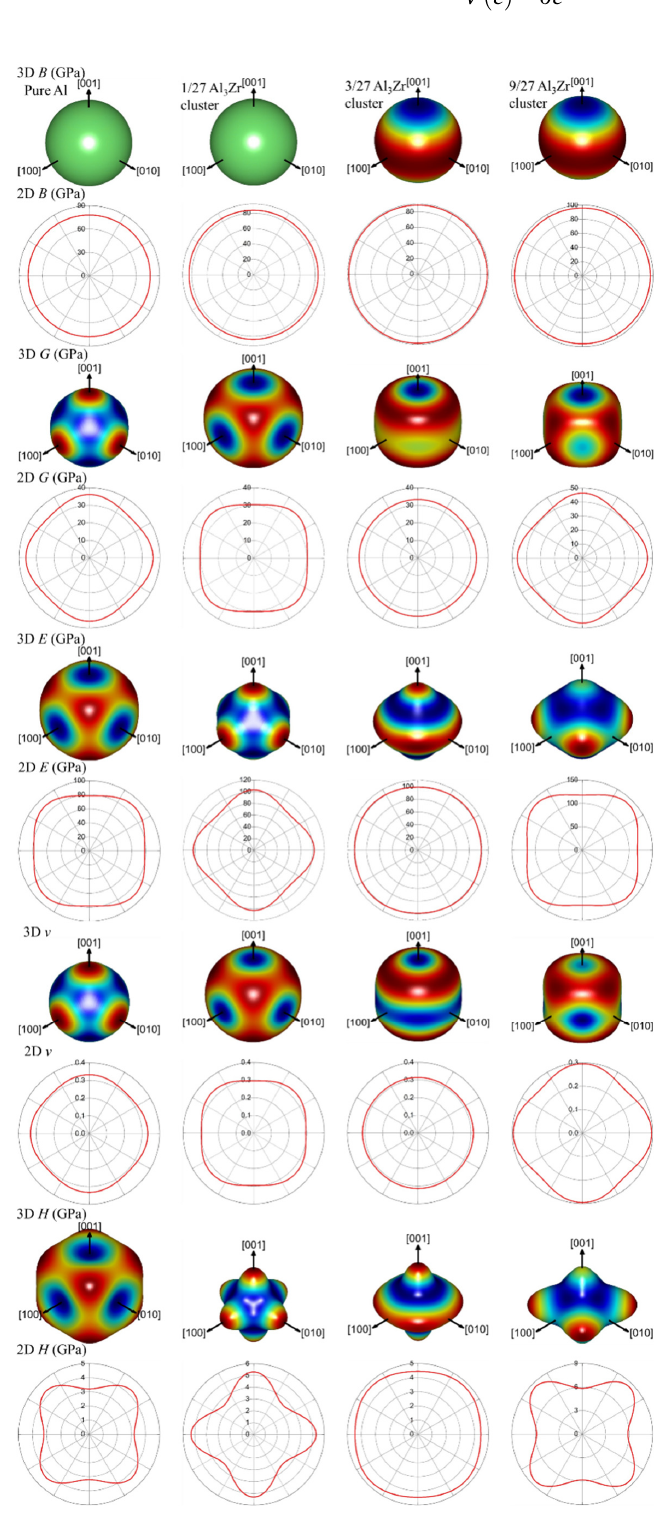
Figure 4. 3D and 2D features of the calculated anisotropy of bulk modulus B , shear modulus G , Young’s modulus E and Poisson’s ratio ν .